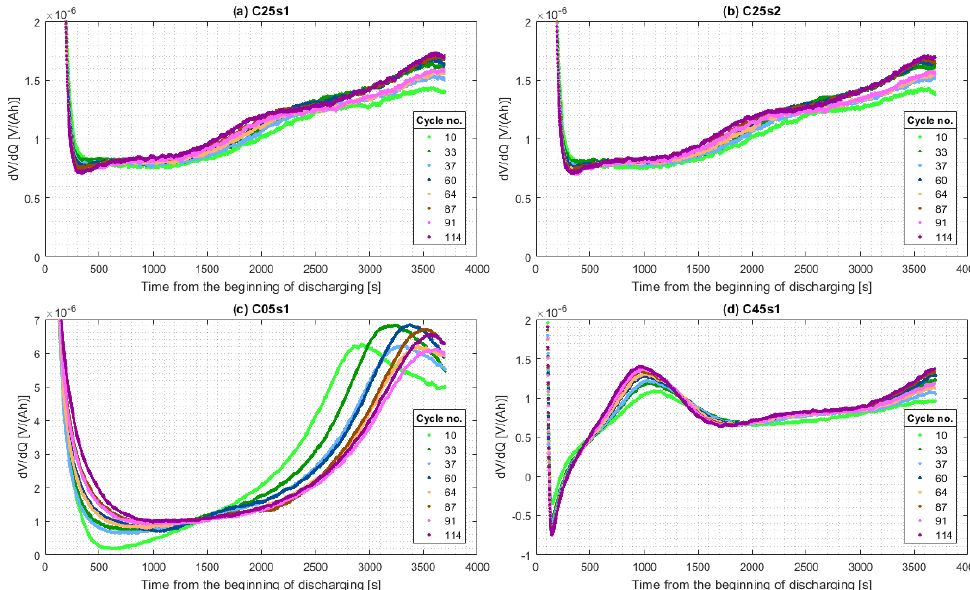
Figure 9. dV/dQ plots for C discharge mode samples for selected cycle numbers—the first and the last cycle of each metacycle. Denomination of the sub-figures corresponds to the Table